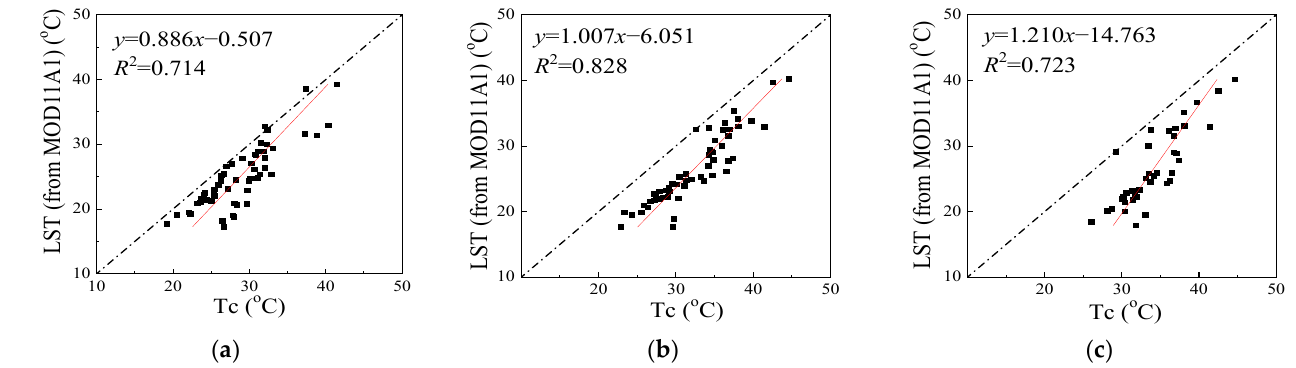
(Figure S3) shows the linear regressions between the LST (time of passing territory: 11:30 a.m.) and Tc (measured at 11:30 a.m.) in same pixel (sample number is 58). The R 2 values here ranged from 0.714 to 0.828, which were a little lower than the results of [40] in Hetao irrigation district of Inner Mongolia Autonomous Region. Those values of LST fused from the Landsat 8 images (30 m) and MOD11A1 data (1 km) might have more precision in large irrigation districts. Regardless, the R 2 values near 0.8 indicate that the retrieved LST directly is reliable.